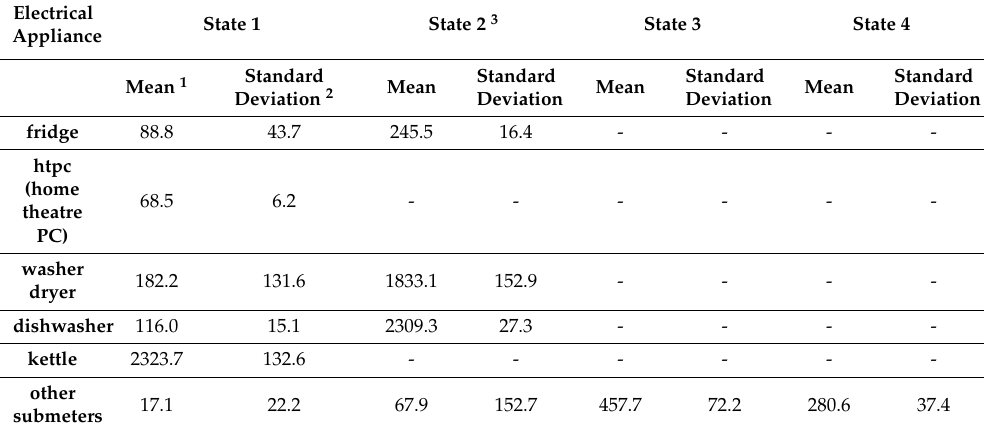
Figure 6. Considered historical power demand on two typical days in House 1 from the UK-DALE dataset parsed in this paper. The thin blue line in ( a , c ) shows the total (whole-house) power demand in the mains; the stacked, filled, and colored blocks show the power demand by the concerned individual electrical appliances and all other submeters [32] considered together and treated as a single individual in the power absorptions also concerned in load disaggregation. Base load in ( b , d ) exists in the house. Table 1. Electrical appliances concerned and considered for load disaggregation in this paper.